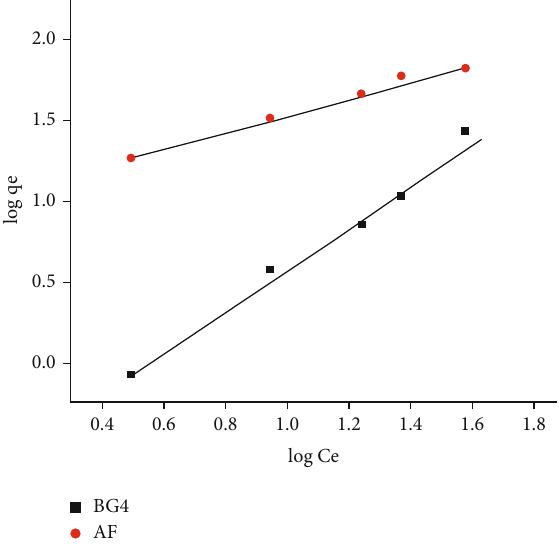
Figure 9: E ff ect of contact time on the dye removal of HUAC.